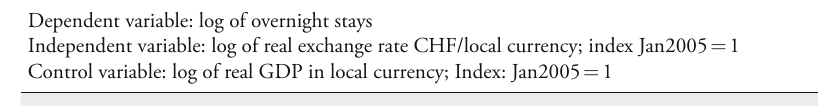
Table 5: Seasonal Specialisation of